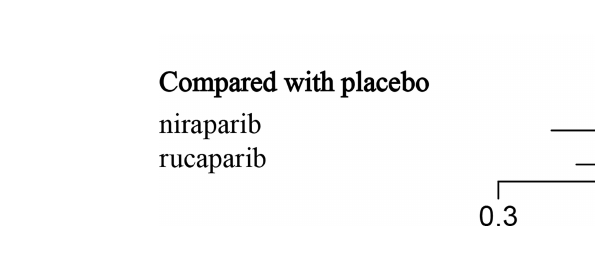
FIGURE 8 | The forest plot of PFS in HRD-negative patients.